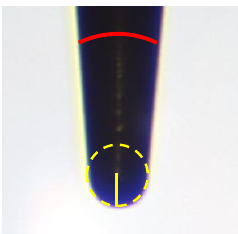
Fig. 1. The solid lines with red and yellow are angle and radius of a LED probe,